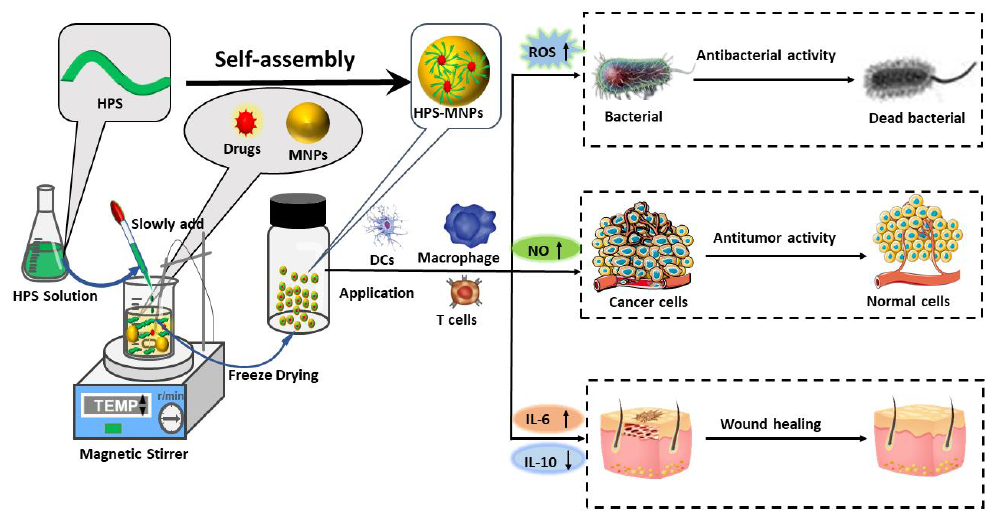
Figure 2. Fabrication and application of HPS-MNPs. ( ↑ : Increase; ↓ : Decrease).